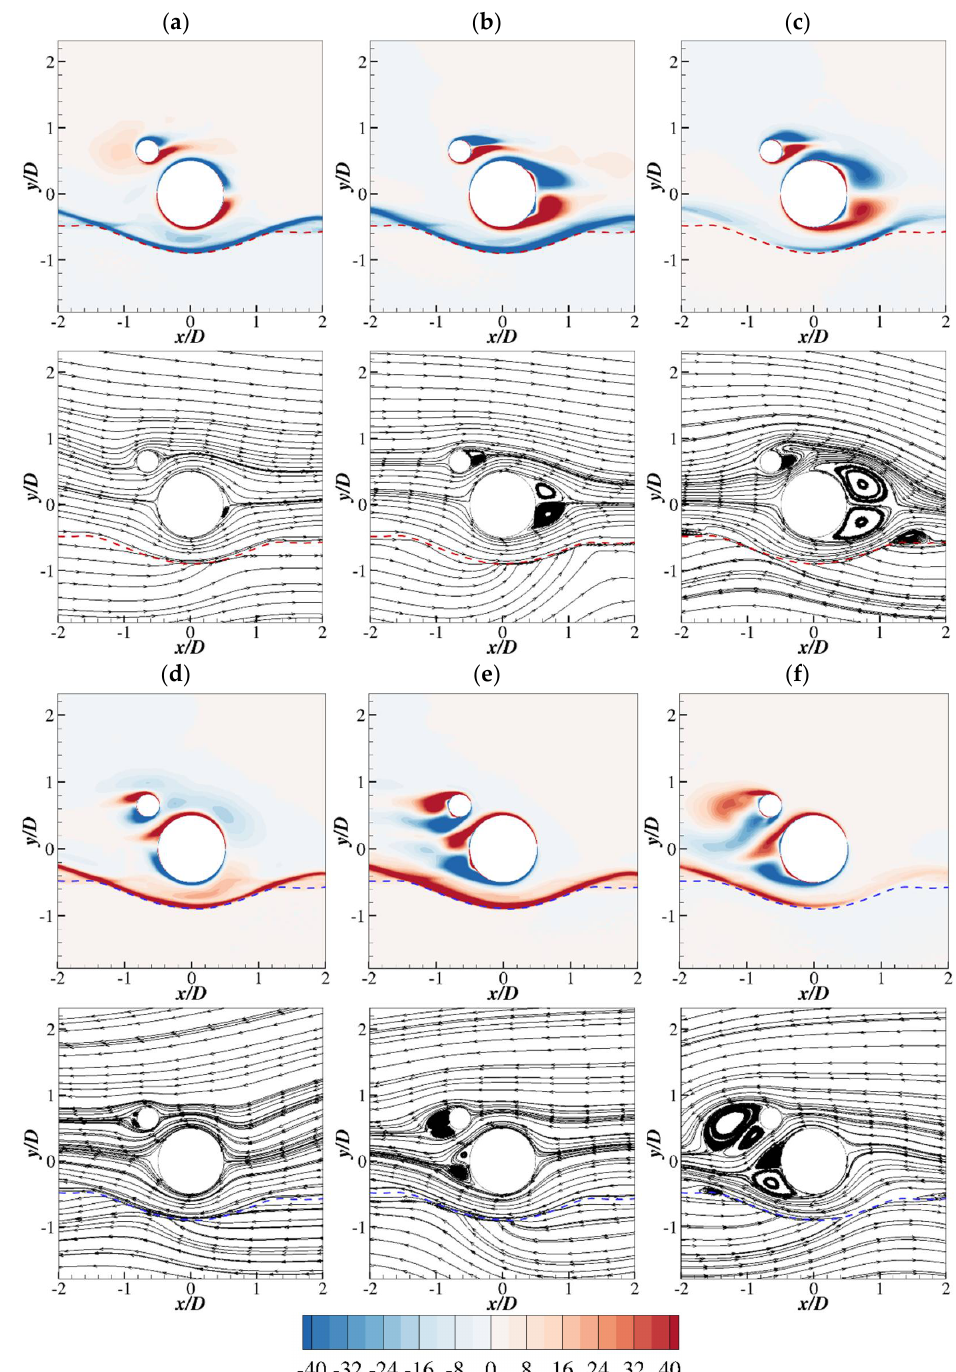
Figure 13. The phase-averaged spanwise vorticity and the streamlines for the piggyback pipeline with α = 45 ◦ at the phase of ( a ) T w /6; ( b ) T w /3; ( c ) T w /2; ( d ) 4 T w /3; ( e ) 5 T w /6; ( f ) T w . The dashed lines denote the iso-surface identified by φ =